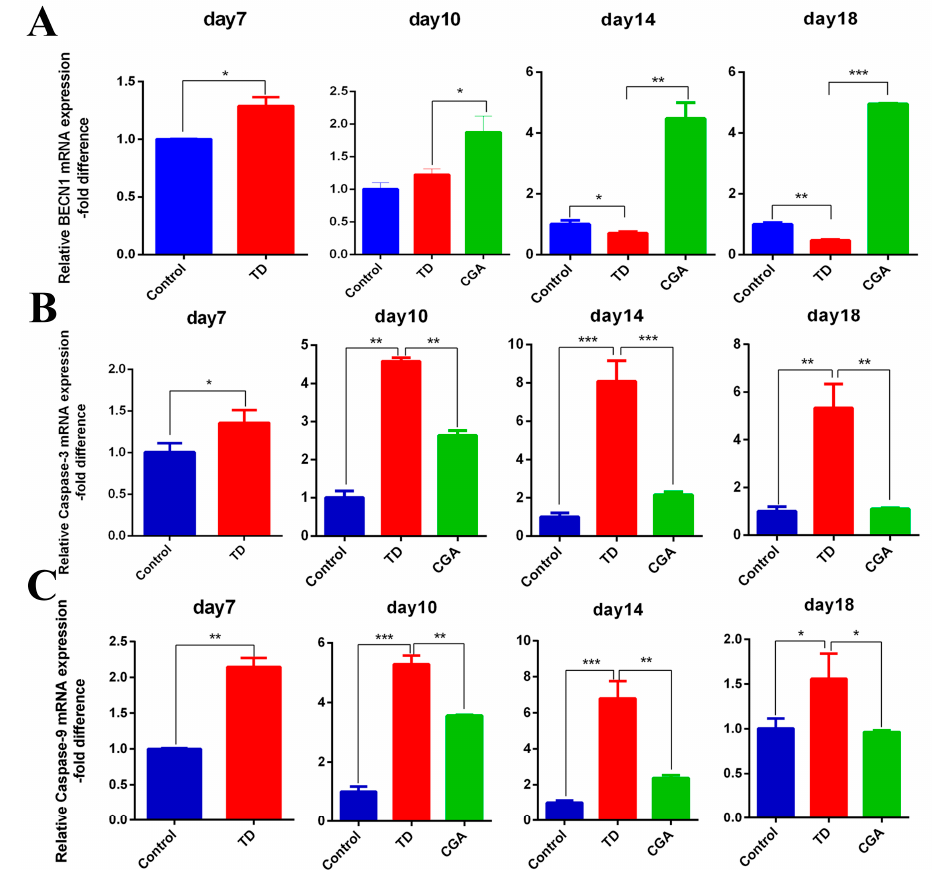
Figure 6. CGA regulates expression of apoptotic and autophagic genes in growth plate. ( A–C ) The relative mRNA expression of BECN 1, Caspase-3, caspase-9 in tibial growth plate were measured by RT-qPCR at days 7, 10, 14 and 18. GAPDH was used as an internal control. All of the data represent means ± SD of three independent experiments. * p < 0.05, ** p < 0.01, *** p < 0.001.